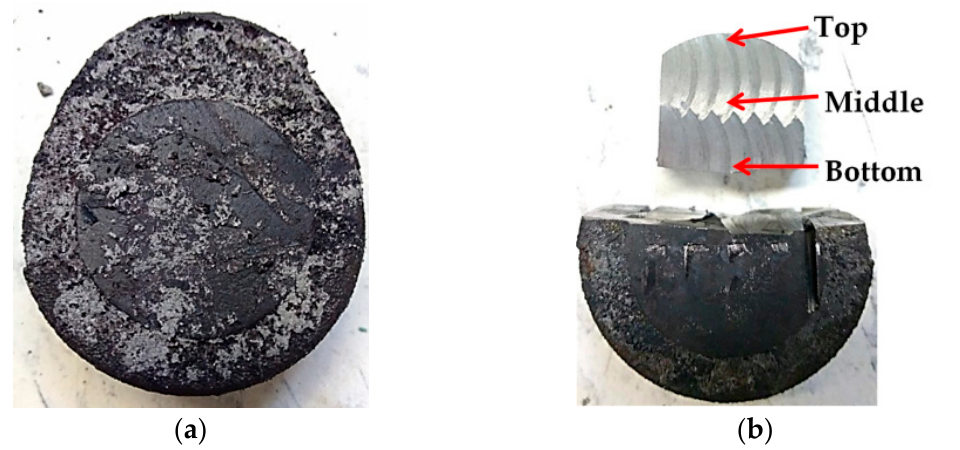
Figure 2. Lobe taken from camshaft showing ( a ) the sample heat treated and ( b ) the three regions analyzed from top to bottom.